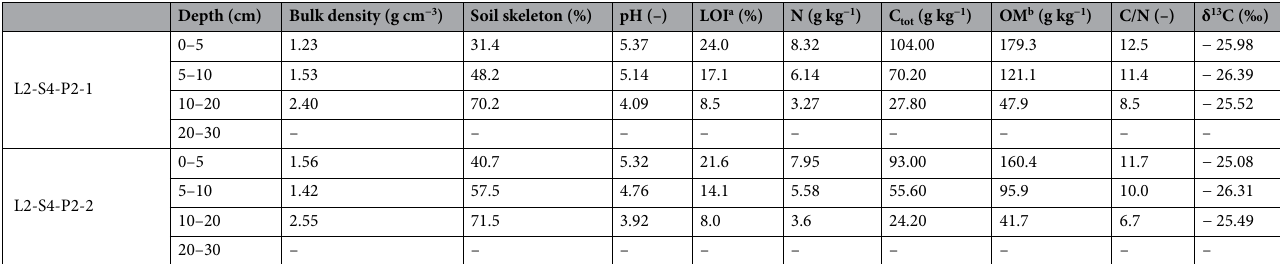
Table 2. Physical and chemical characteristics of the investigated soils. a LOI (loss on ignition) = based on weight percent loss of ashed material during pre-treatment for Pu analysis. b OM (organic matter) = total organic C (C tot ) × 1.72; C tot was determined by a CHN analyzer. c L1 = Location 1 (L2 = Location